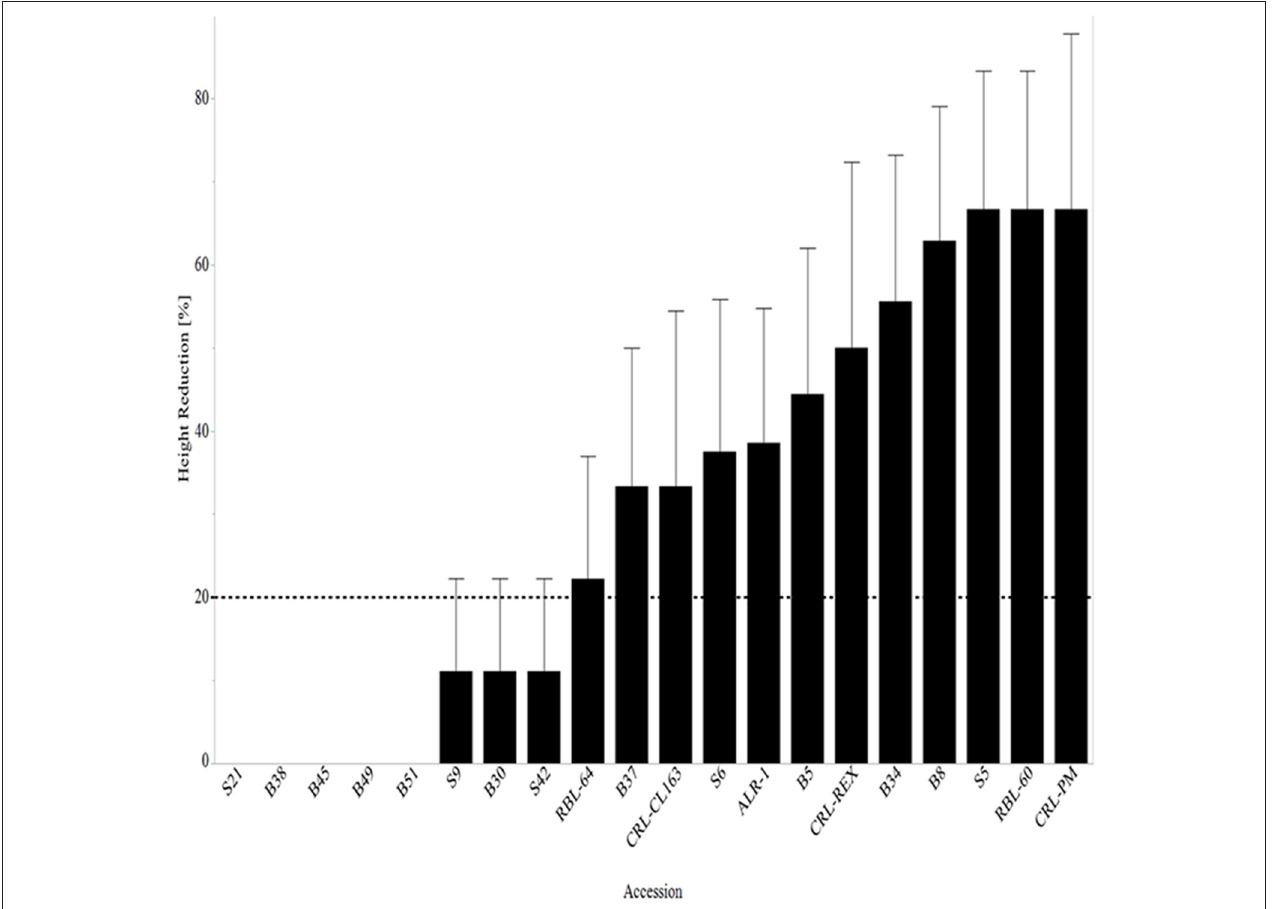
FIGURE 5 | Mean height reduction 14 days after complete submergence stress treatment arranged from lowest reduction to the highest reduction in height. The line at 20% represents all lines with ≥ 20% reduction in height. RBL, Rice breeding line; CRL, cultivated rice